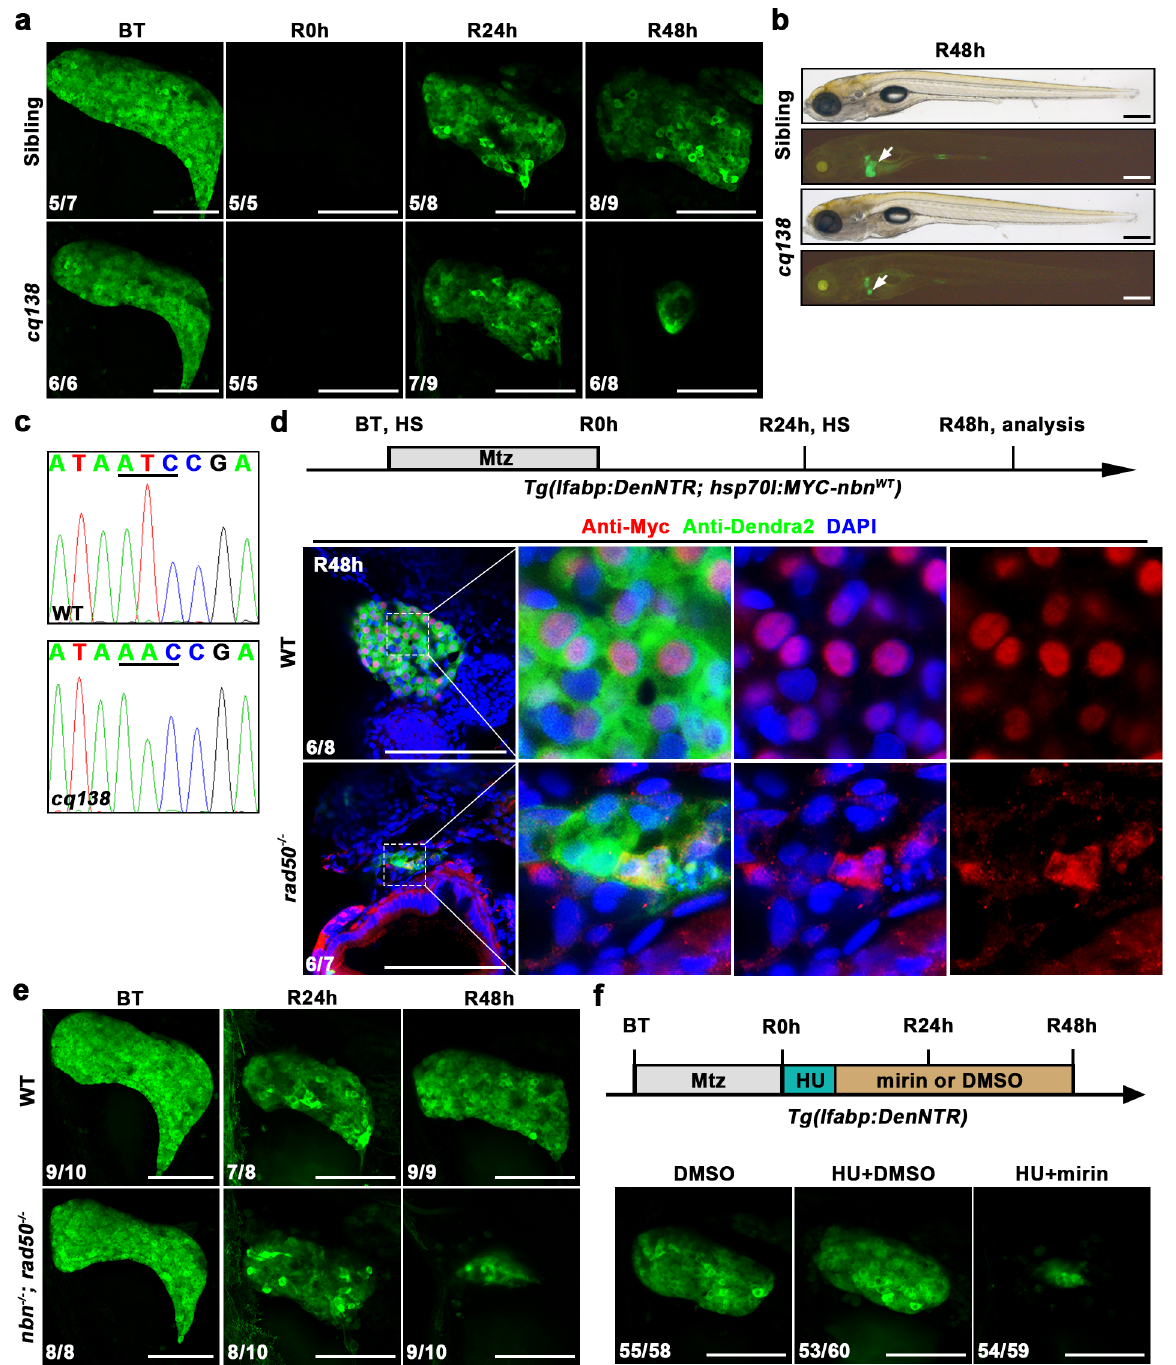
Fig. 3 The components of MRN complex are required for liver regeneration. a Confocal projection images showing the regenerating livers of sibling and cq138 mutant from BT to R48h under the Tg(lfabp:DenNTR) background. b Bright- fi eld and epi fl uorescence images showing the morphological appearance and regenerating livers (arrows) of sibling and cq138 larvae at R48h, respectively. c Sequencing result displaying the mutation site in rad50 . d Schematic illustration of Mtz treatment and analysis at R48h. Single optical section images showing Myc (red), Dendra2 (green), and DAPI (blue) staining in regenerating livers of wild-type and cq138 mutant at R48h under the Tg(lfabp:DenNTR) background. Note that Myc-tagged Nbn WT is mislocalized to the cytoplasm in rad50 -/- larvae. e Confocal projection images showing the regenerating livers of wild-type and nbn -/- rad50 -/- double mutant from BT to R48h under the Tg(lfabp:DenNTR) background. f Schematic illustration of HU and mirin treatment and analysis at R48h. Confocal projection images showing the regenerating livers of larvae treated with or without mirin under HU exposure. Numbers indicate the proportion of larvae exhibiting the expression shown. Scale bars, 100 μ m ( a , d , e , and f ) and 300 μ m b . BT before Mtz treatment, R regeneration time after the withdrawal of Mtz, WT wild-type, DAPI 4 ′ , 6-diamidino-2- phenylindole, HU